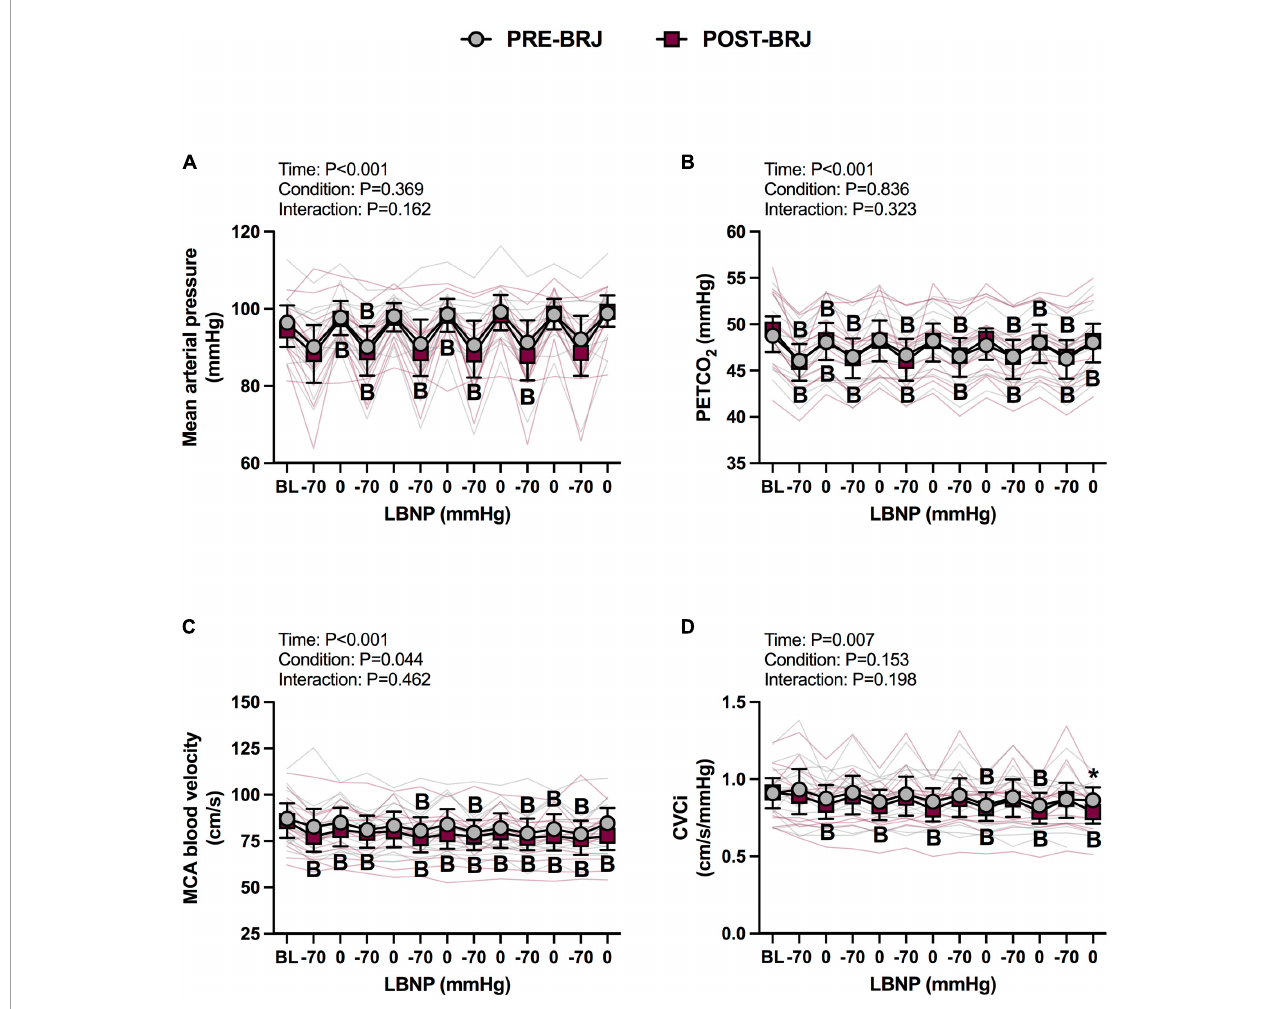
FIGURE3 Individual responses and absolute means with 95% confidence intervals for mean arterial pressure (A) , end-tidal CO 2 tension (B) , middle cerebral artery blood velocity (C) , and cerebrovascular conductance index (D) at the last minute of baseline (BL) and during each 30 s interval of oscillatory lower-body negative pressure (LBNP) before (PRE–BRJ) and 3 h after beetroot juice consumption (POST–BRJ). Linear mixed-effect models were used to compare mean values within a given variable. Post-hoc tests using the Bonferroni’s correction for multiple comparisons were used where appropriate. B = different from baseline ( P ≤ 0.05). *Different from PRE-BRJ ( P ≤